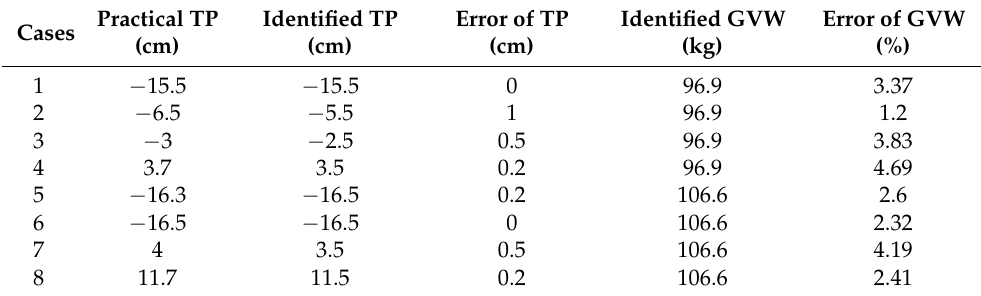
Table 4. Identified results of the TP and the GVW.